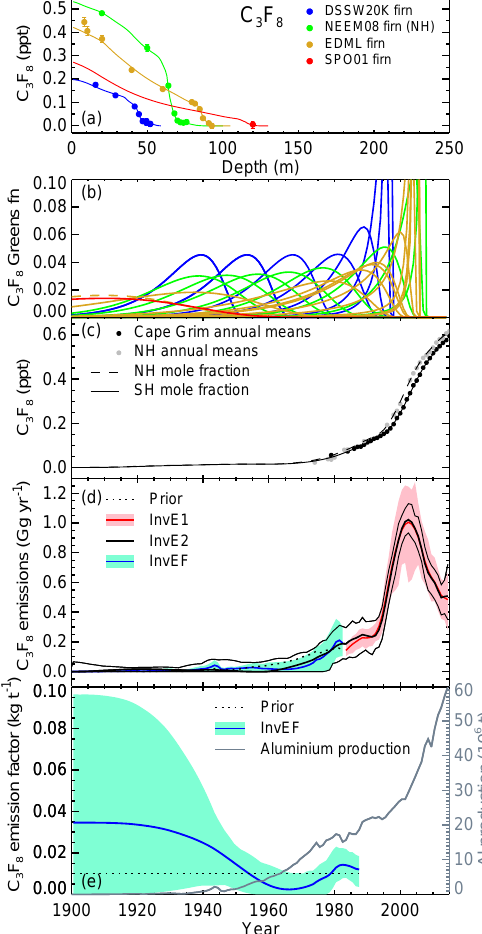
Figure 4. Inputs and results for the C 3 F 8 inversions. Panels, line styles and symbols are as in Fig.